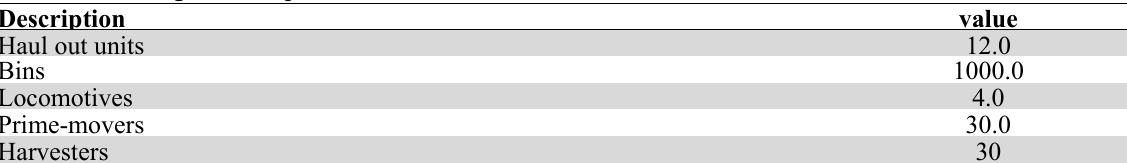
Resources Management inputs